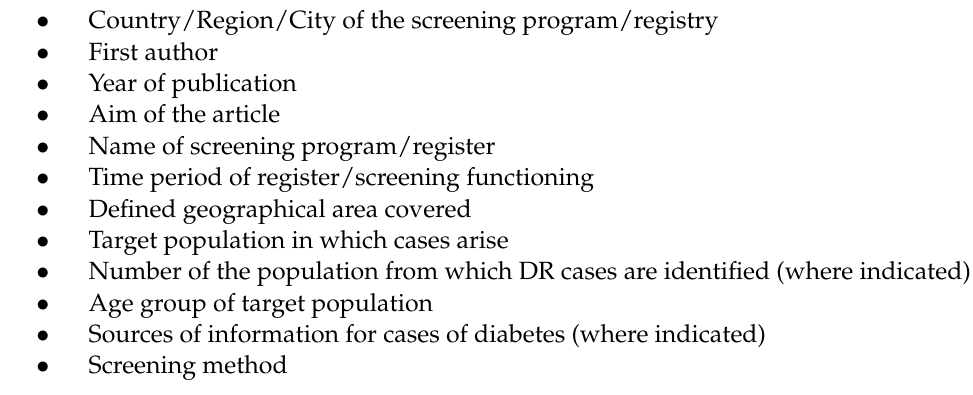
Figure 1. Flow diagram describing the systematic search for publications on screening programs and registries for DR in EU countries.